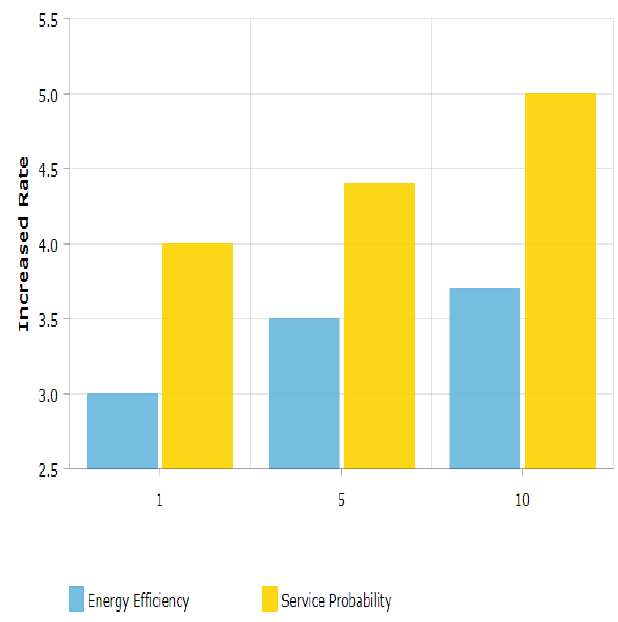
Figure 10. Comparison of results with different